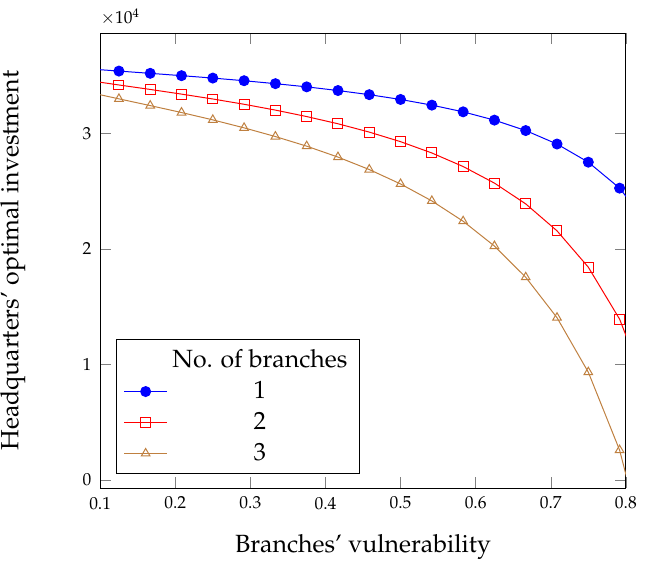
Figure 4. Optimal investment for the headquarters in the full liability case.